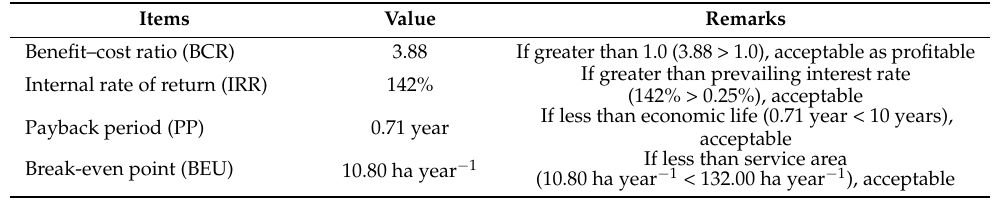
Table 10. Project worth evaluation of large